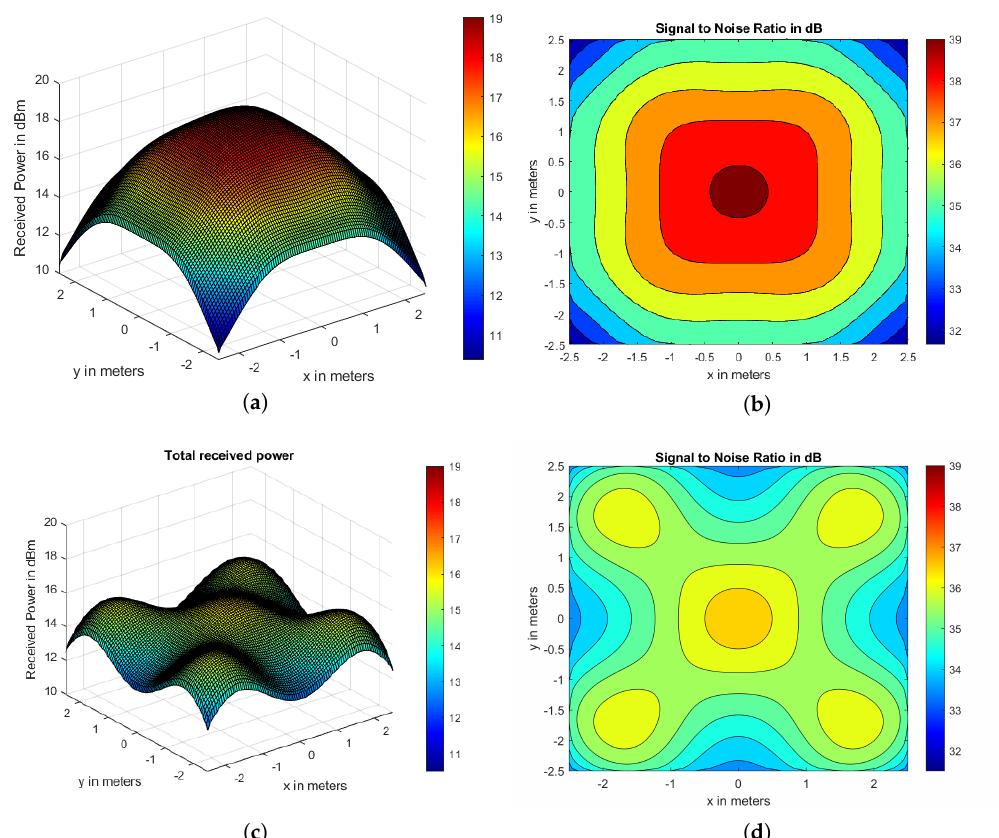
Figure 7. Received power for ( a ) CLQ ( c ) CoIQ-9 with respective SNR contours in ( b , d ). (b) Effects of Transmitter Locations on RMS Delay